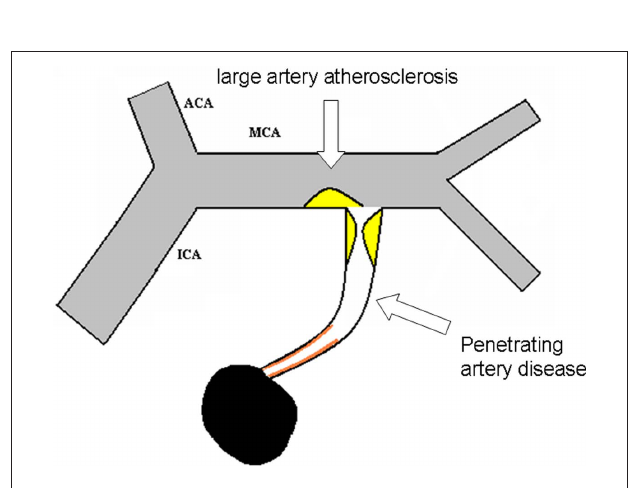
Figure 2 | Detailed illustration for intracranial large artery atherosclerosis and penetrating artery